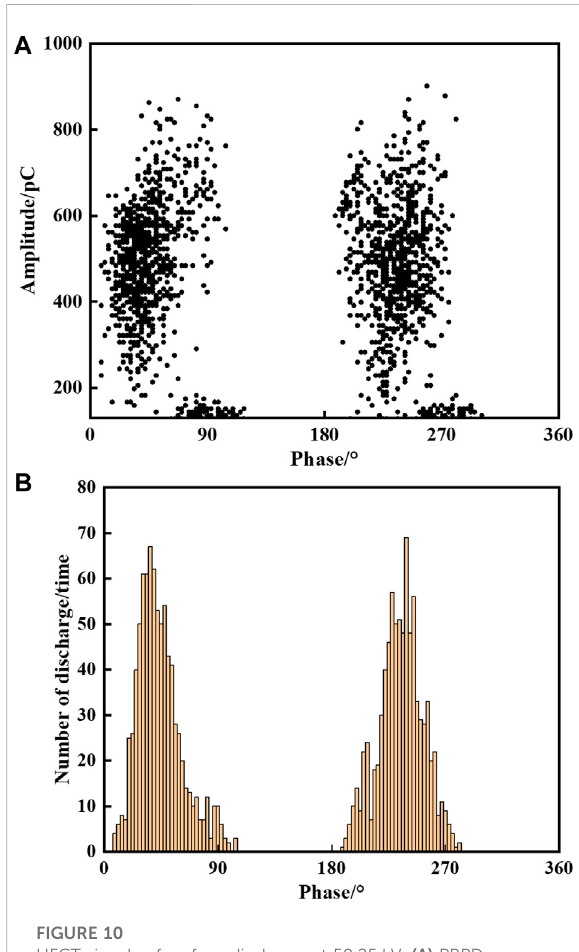
FIGURE 9 UHF signals ofsurfacedischarge at45.7 kV. (A) PRPD pattern. (B) φ − n.